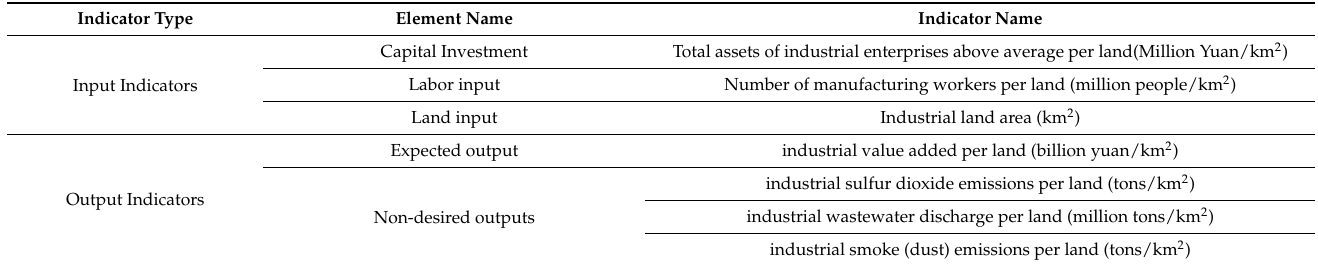
Table 1. Input-output indicators for measuring GUEIL.